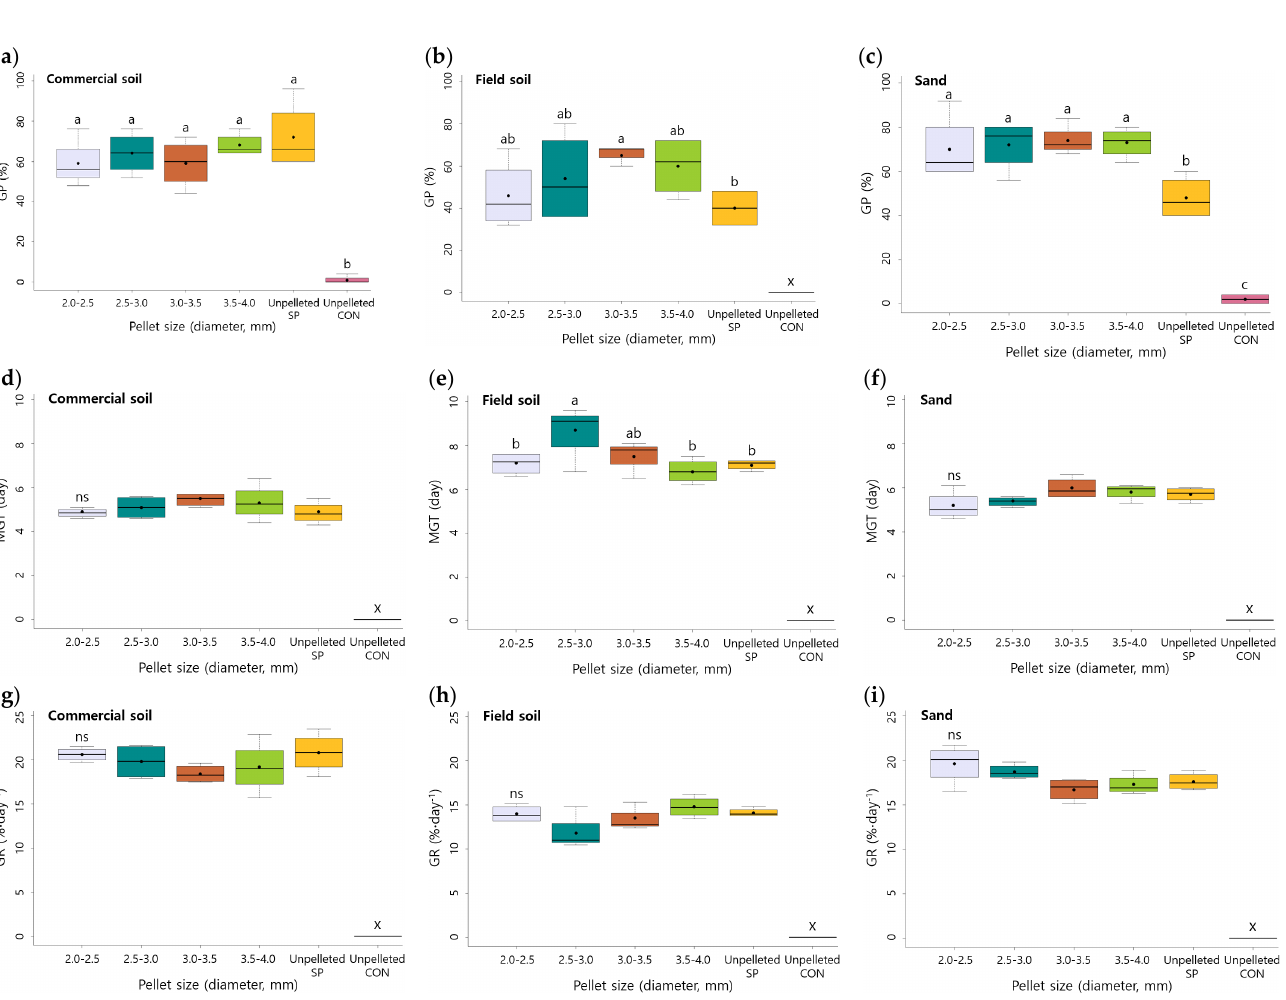
Figure 2. Effect of the soil substrate and size of pelleted seeds on the ( a – c ) germination percentage, ( d – f ) mean germination time, and ( g – i ) germination rate (GR) of A. sikokianus seeds. Box plot showing germination traits in different sized pelleted seeds. Different letters indicated significant differences within a pelleting size at p < 0.05, according to Duncan’s multiple test, ns indicates non-significance. The box plots illustrate the results from four replicates. The bottom and top of the boxes show the 25 and 75 percentiles, respectively. The median is indicated by the black horizontal line, and the ends of the whiskers represent the minimum and maximum values. x: values are not available because of less than 2% GP.